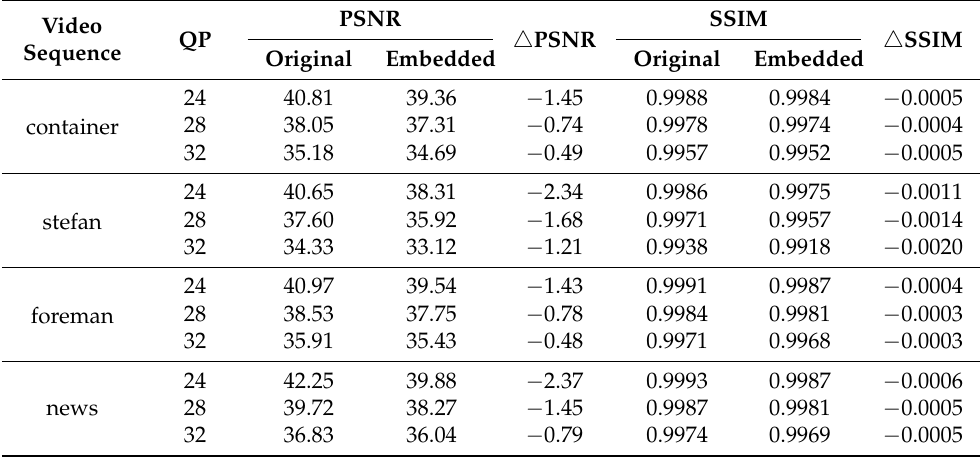
Table 4. Average PSNR and SSIM before and after